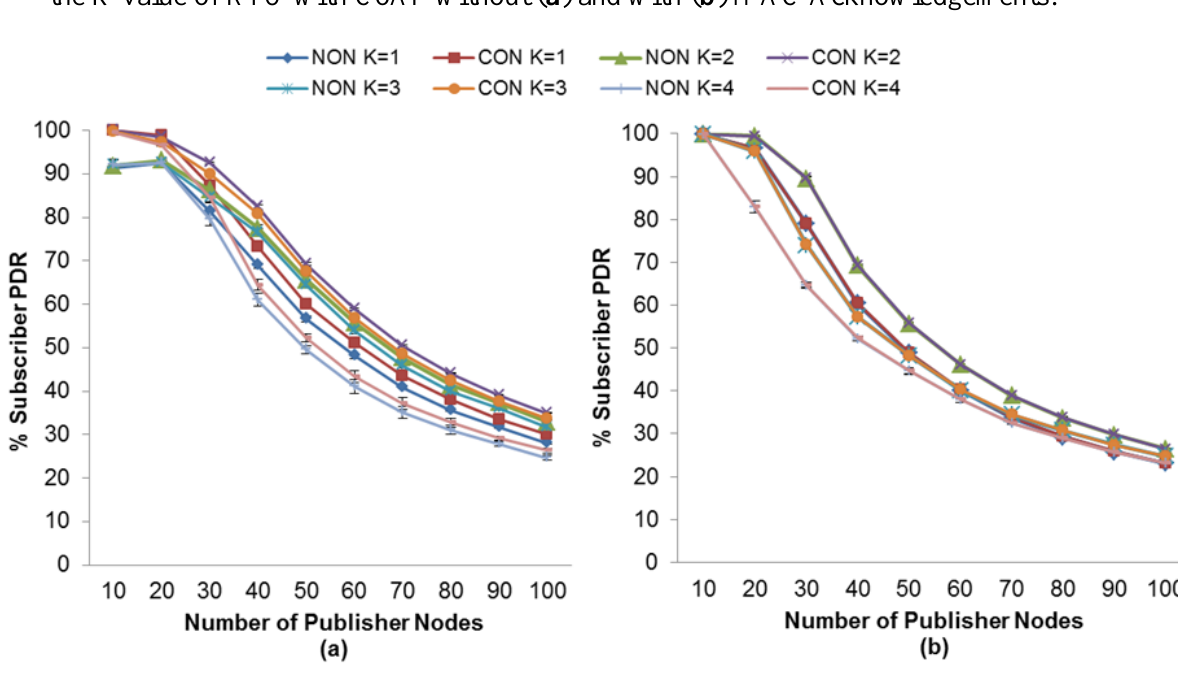
Figure 5. Effect of the number of Publisher Nodes on the Subscribers PDR depending of the K value of RTO with CoAP without ( a ) and with ( b ) MAC